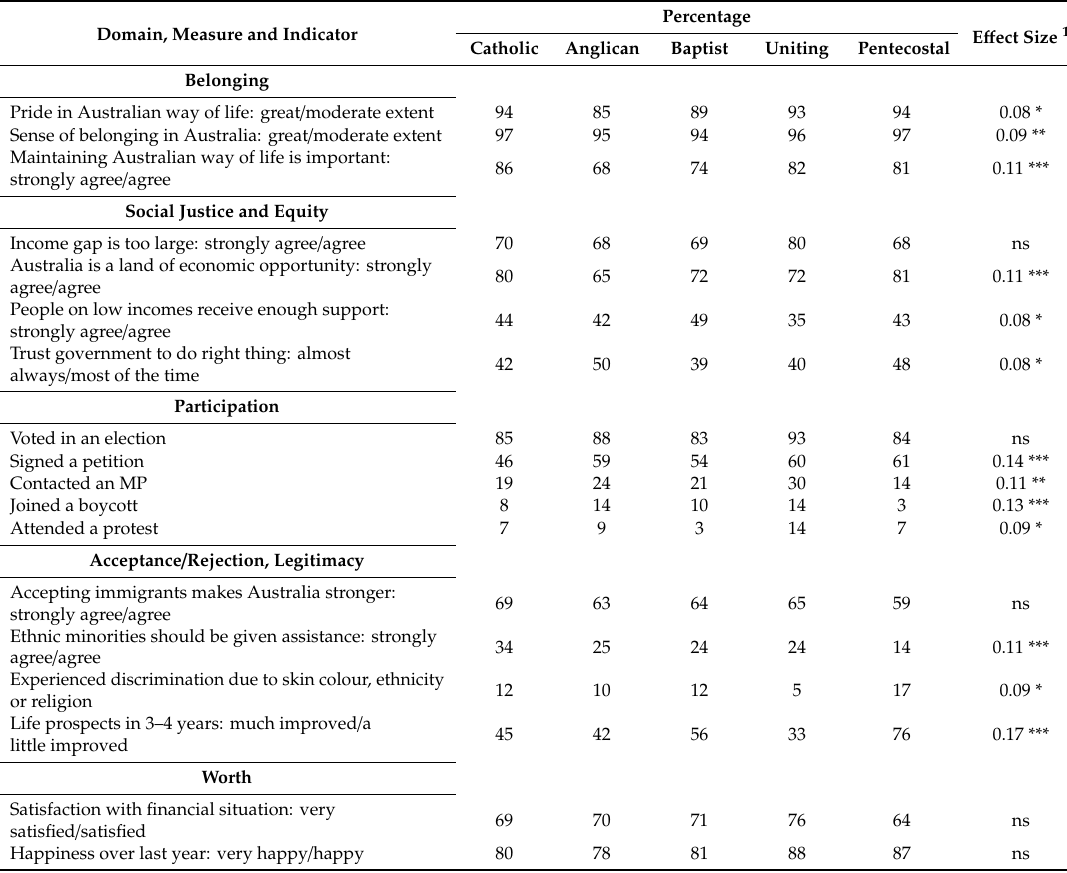
Table 4. Descriptive statistics for social cohesion indicators, NCLS denominational